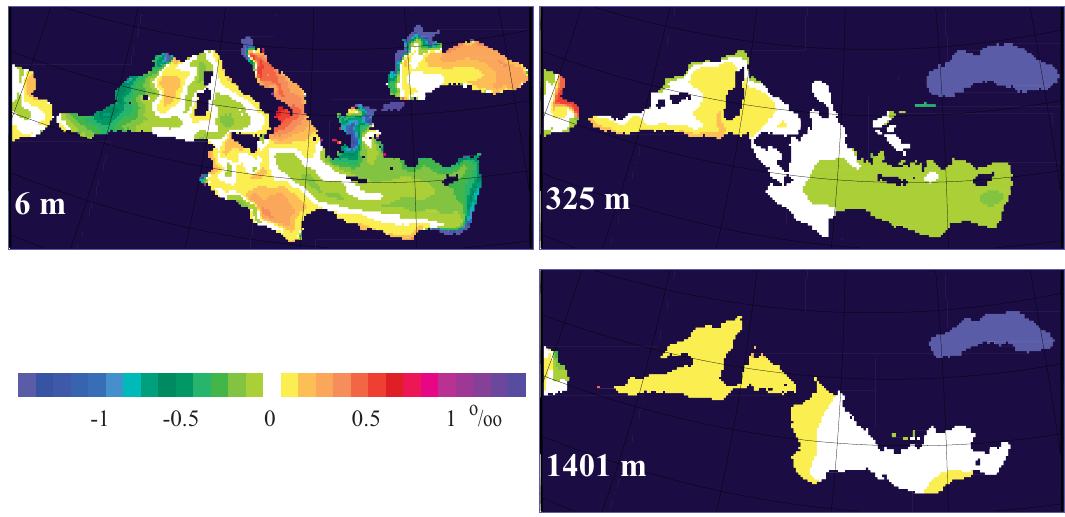
Fig. 4. Difference between simulated (CTL) and climatological annual mean salinity (MEDATLAS) for the surface, 325m and 1401m. Contour interval is 0.1‰. White indicates deviations smaller than